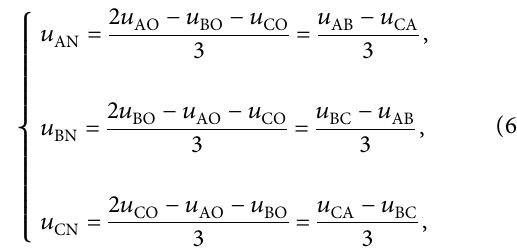
Figure 3: System equivalent circuit of the HCSY-MG grid-connected